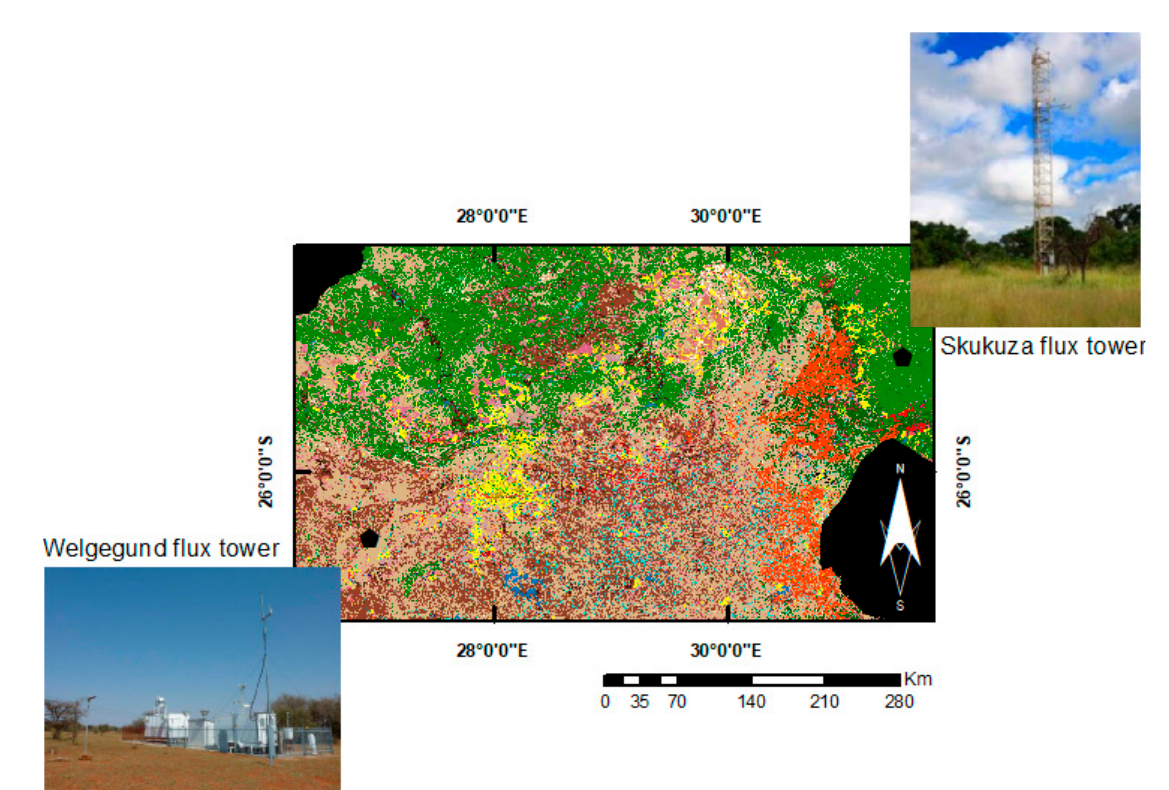
Figure 1. Skukuza and Welgegund flux tower sites. Welgegund image sourced from https://www.welgegund.org/.